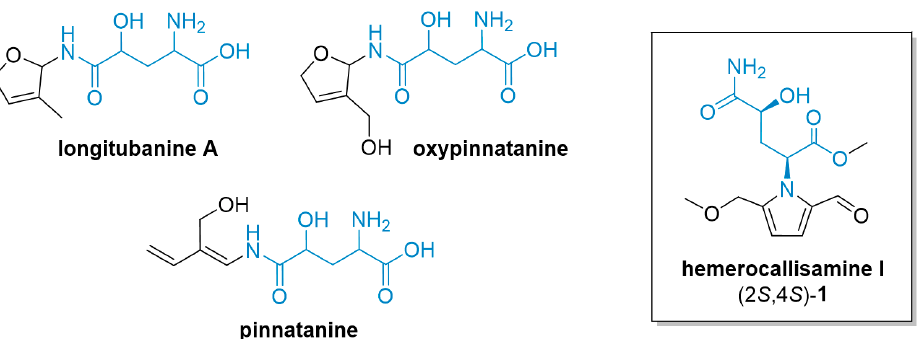
Figure 1. Structures of 4 ‐ hydroxyglutamine derivatives isolated from daylily Hemerocallis fulva . With the aim of smoothly constructing the 4 ‐ hydroxyglutamine framework, the pub ‐ lished synthesis of (2 S ,4 S ) ‐ 1 started with commercially available cis ‐ 4 ‐ hydroxy ‐ L ‐ proline ( 2 ) to deliver amine 3 in 48% yield over 7 steps [7] (Scheme 1A). The critical step, Maillard ‐ type condensation with dihydropyranone 4 , provided the functionalized pyrrole (2 S ,4 S ) ‐ 5 only in a moderate yield of 37%. After the final deprotections and selective O ‐ methyla ‐ tion, an 11 ‐ step synthesis of hemerocallisamine I ( 1 ) was successfully concluded with an 11.7% overall yield.